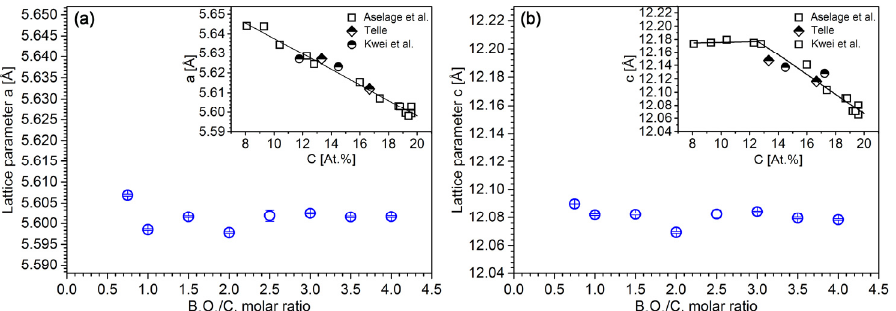
Figure 6. Dependence of hexagonal lattice parameters a ( a ) and c ( b ) of boron carbides synthesized at 1900 °C for 20 min on the starting molar ratio of B 2 O 3 /C, the insets show the dependence of the lattice parameters on carbon content, data from Aselage et al. [30], Kwei et al. [31] and Telle [32].